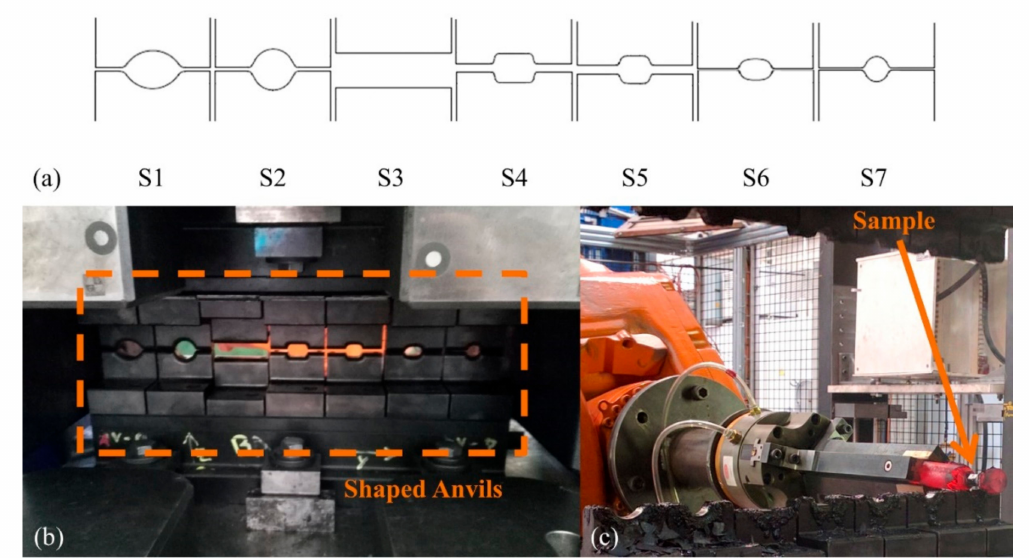
Figure 1. ( a ) Schematic representation of the initial configuration of the representative test, ( b ) representative test anvils and ( c ) steel sample handled by a robotic arm during the